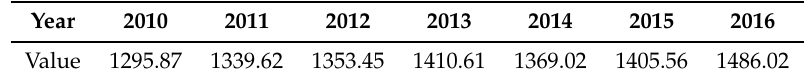
Table 4. The electricity consumption for Shanghai City in China from 2010 to 2016 [Unit: 100 million kwh].